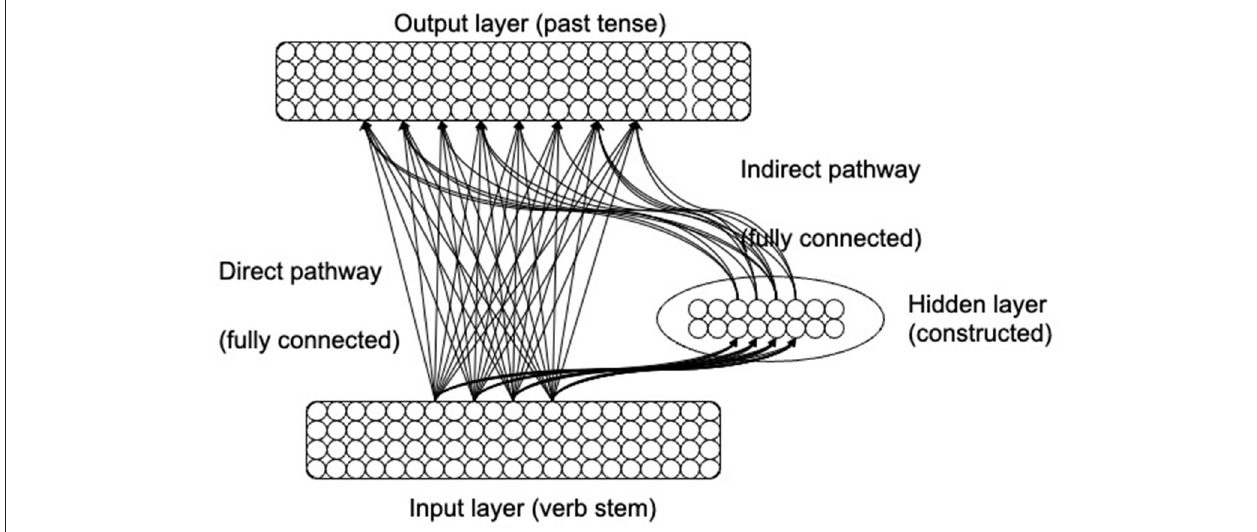
FIGURE 1 | The architecture of the neuroconstructivist past tense